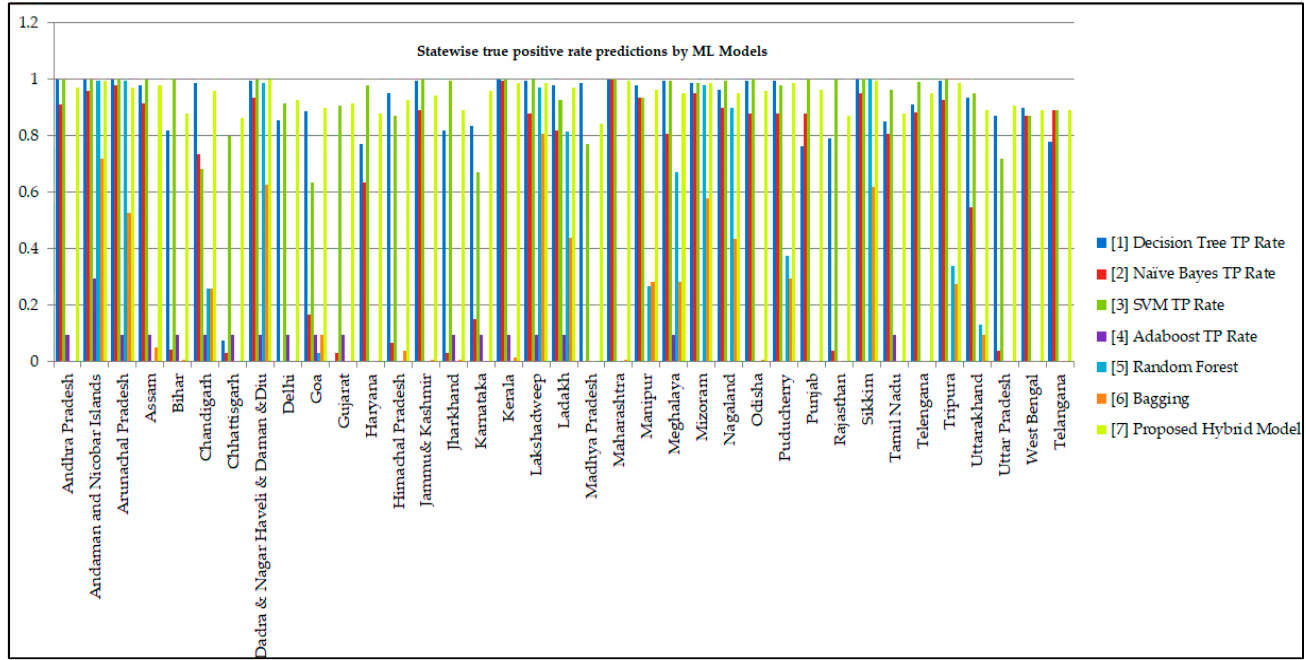
Figure 11. True Positive Rate Predicted by Classification Models for each class.